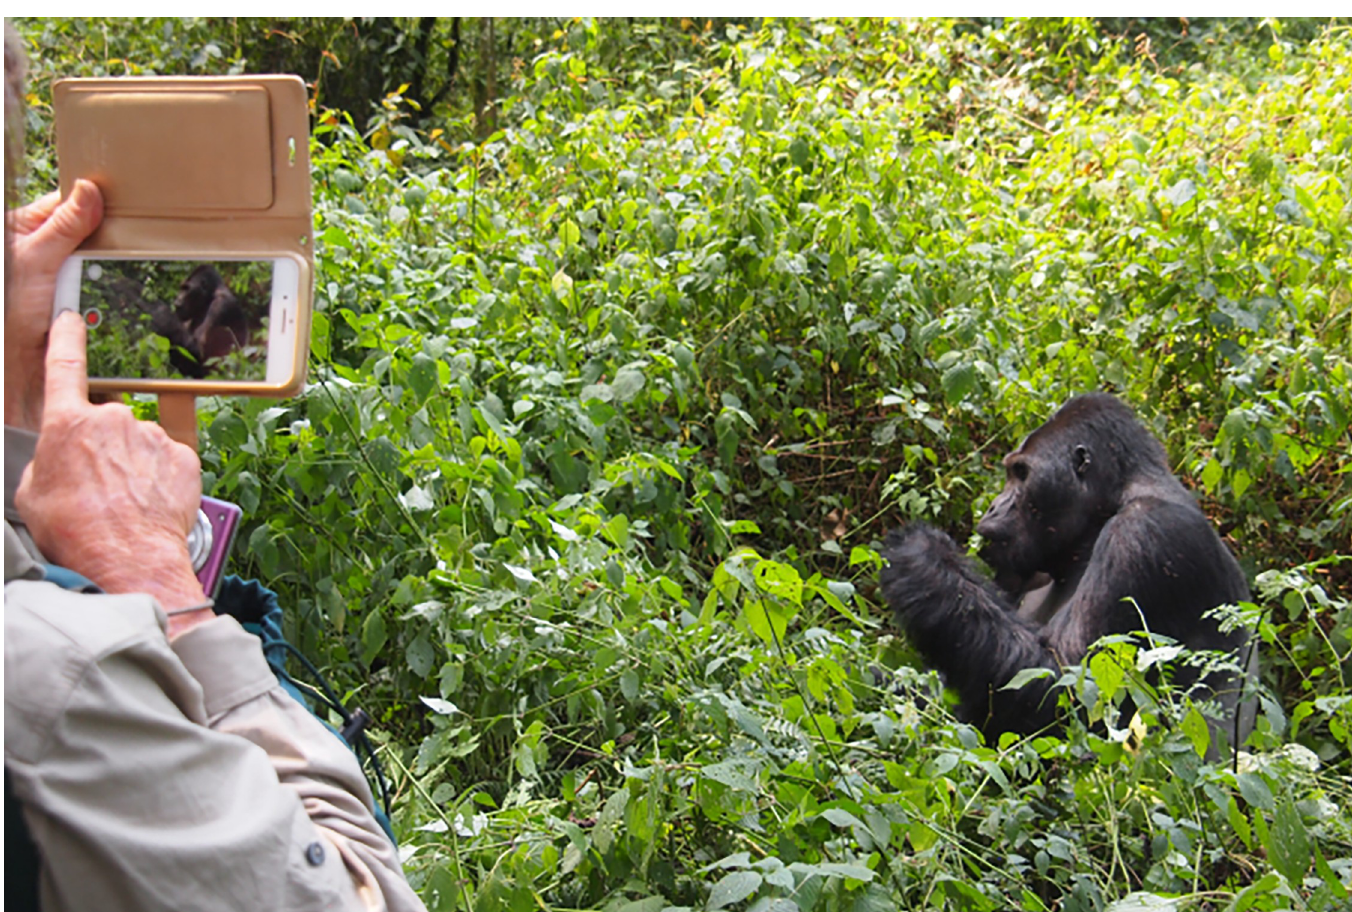
Fig 1. Australian tourist photographing Chimanuka on a smartphone as part of a gorilla tourism experience at Kahuzi-Biega National Park in DRC in July 2017.